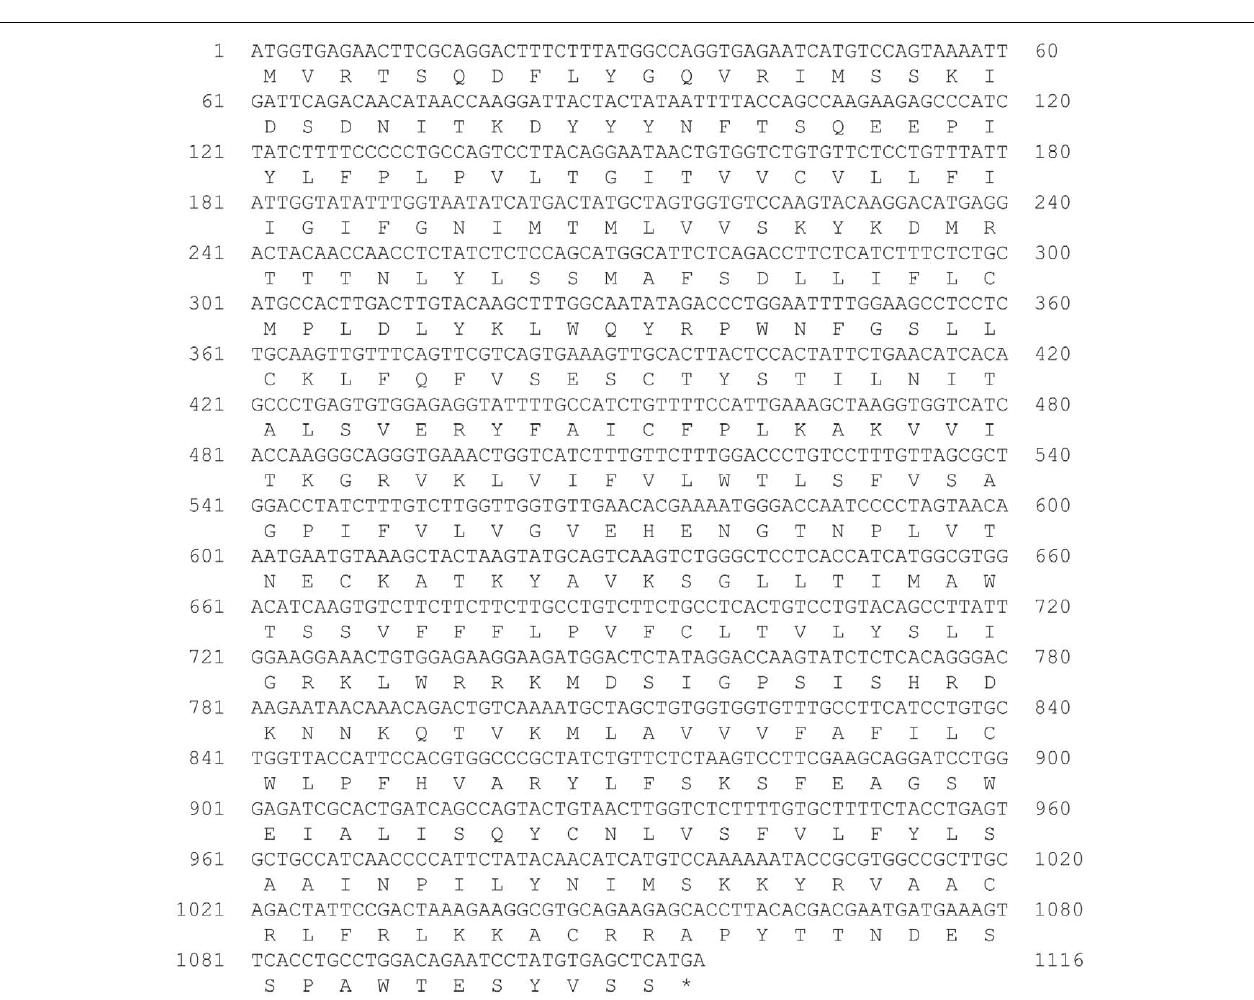
mRNA expression of GHS-Ra in the whole brain, stomach and ventral skin, compared with the respective control ( Figure 9B